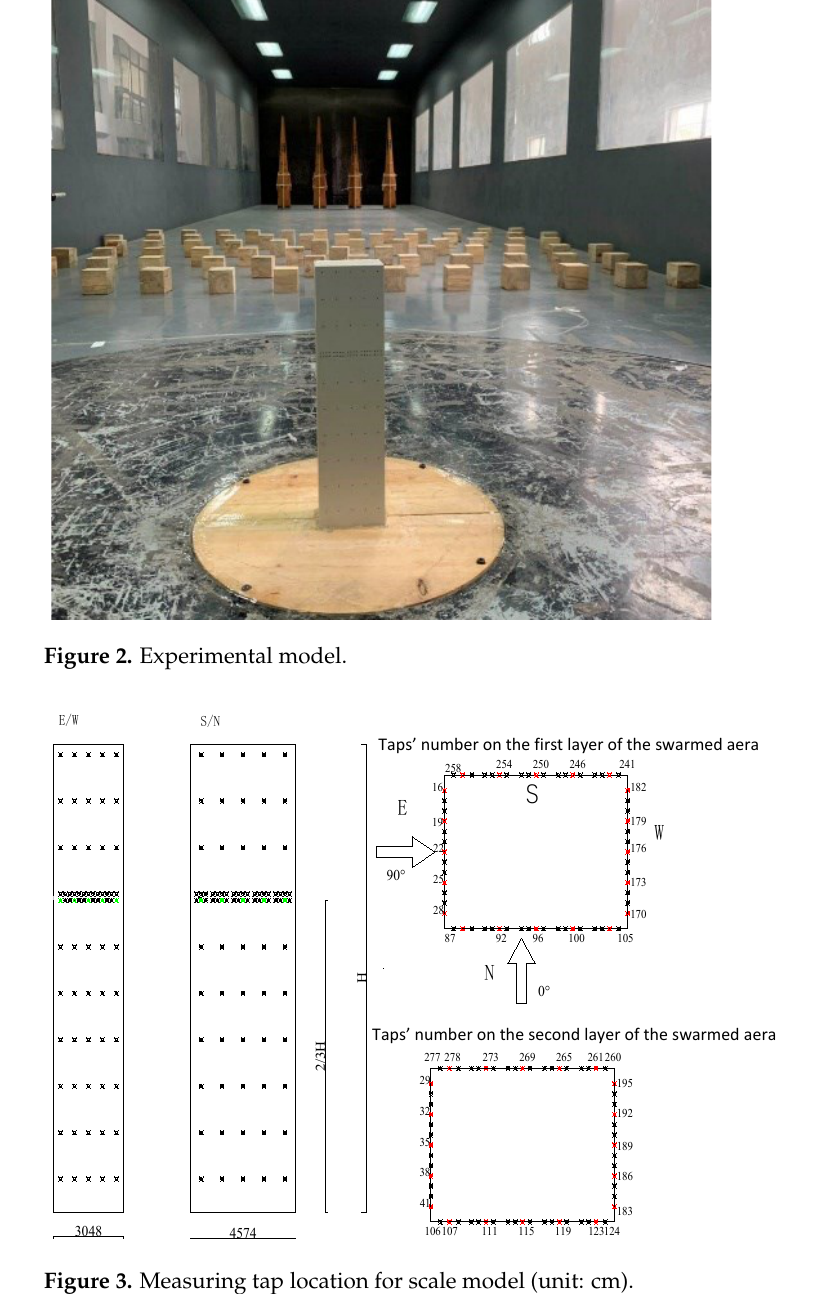
Figure 3. Measuring tap location for scale model (unit: cm).